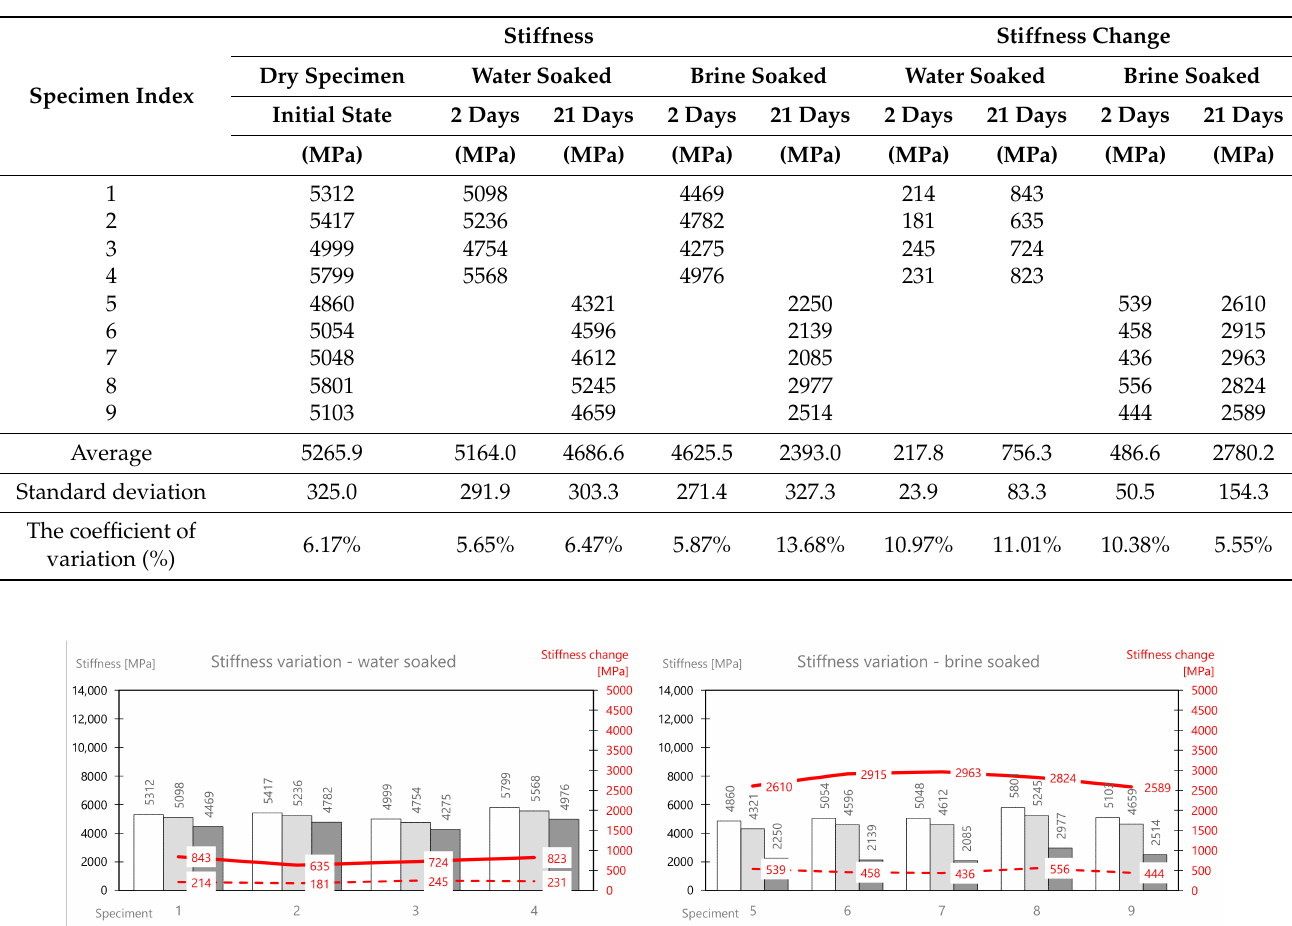
Table 10. MCAS mix stiffness variation via water and brine soaking.